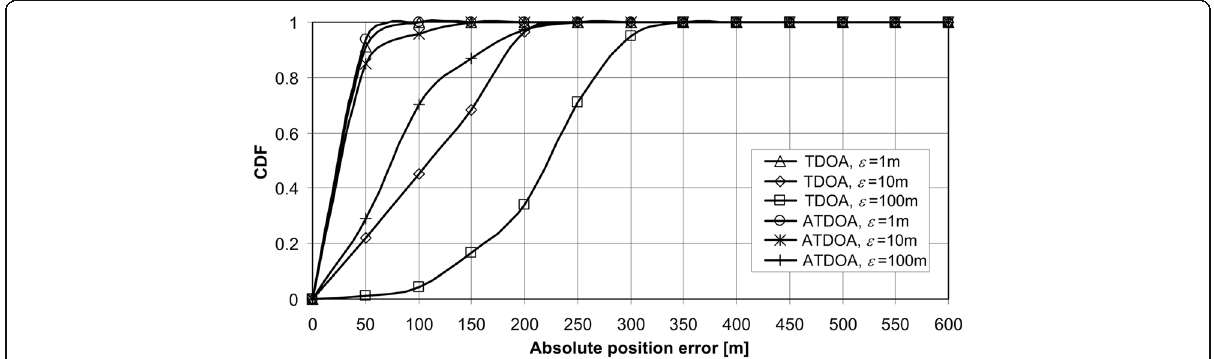
Fig. 6 The CDFs of the absolute position error for the proposed ATDOA method compared with the TDOA method using genetic